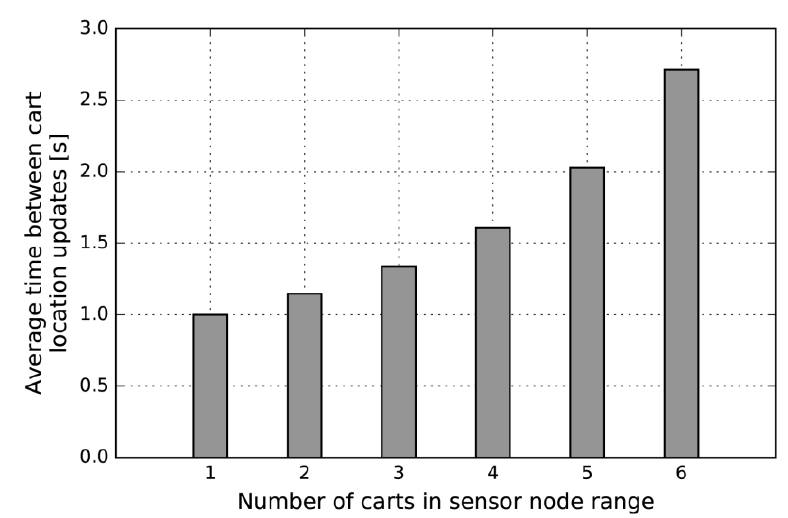
Figure 9. The average time between cart location updates depending on IR package collision probability or, more precisely, on the number of carts in the sensor node range. With a standard deployment density of 1 sensor every 3 m, there is a high probability of multiple sensors in the IR range of the mobile node, further reducing latency.